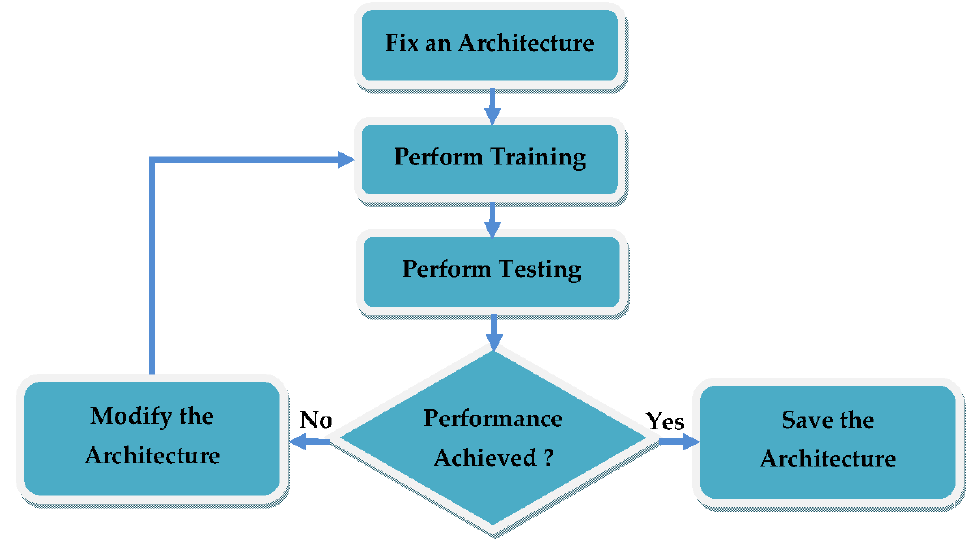
Figure 5. Architecture optimization .